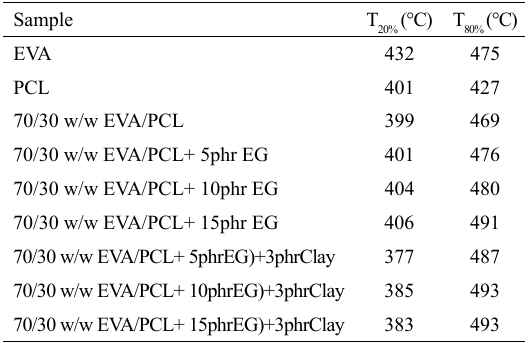
Table 2: Degradation temperatures at 20 and 80% mass for all the investigated samples.